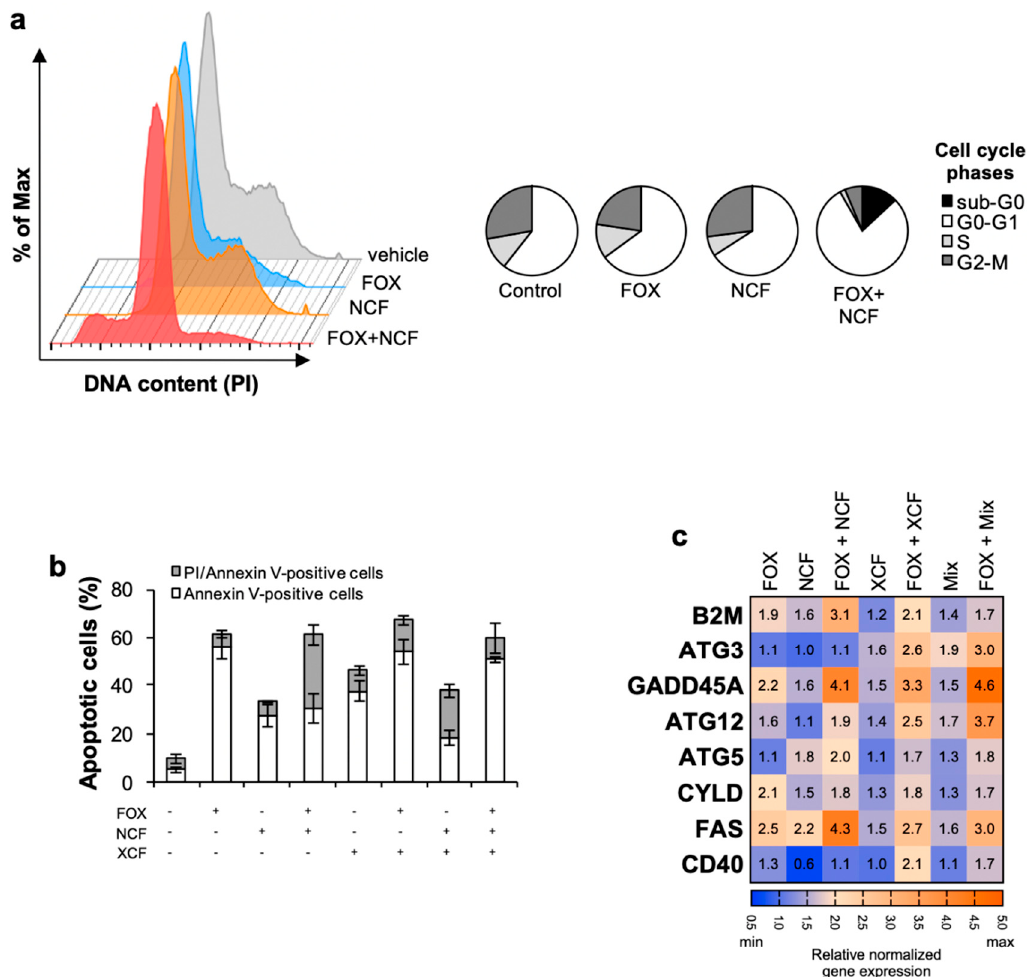
Figure 3. Flavonoids extracts plus chemotherapy induce apoptosis in CR-CSphCs. ( a ) Phase Representative flow cytometry analysis of cell cycle phases distribution in CR-CSphCs (#8) exposed to 0.5 µ M FOX and 12.5 µ g/mL NCF, alone or in combination, for 48 h. DNA content was assessed by propidium iodide (PI) staining; ( b ) percentage of apoptotic CR-CSphCs (#8) treated with 0.5 µM FOX and 12.5 µg/mL NCF, XCF, or both extracts, alone or in combination, for 48 h. The analysis was performed by flow cytometry on CR-CSphCs labeled with propidium iodide (PI) and Annexin-V; ( c ) gene expression analysis of pro-apoptotic genes in CR-CSphCs (#8) after exposure to 0.5 µM FOX and 12.5 µg/mL NCF, XCF, or both extracts (Mix), as compared to control (vehicle) for 48 h. Data are expressed as 2 −ΔΔ Ct expression values normalized to GAPDH and HPRT genes.